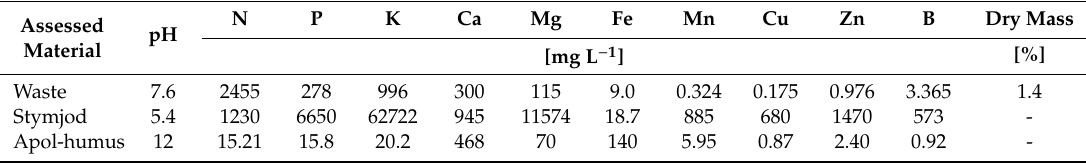
Table 5. Content of elements in the non-centrifuged waste from corn grain biodigestion to methane, Stymjod, and